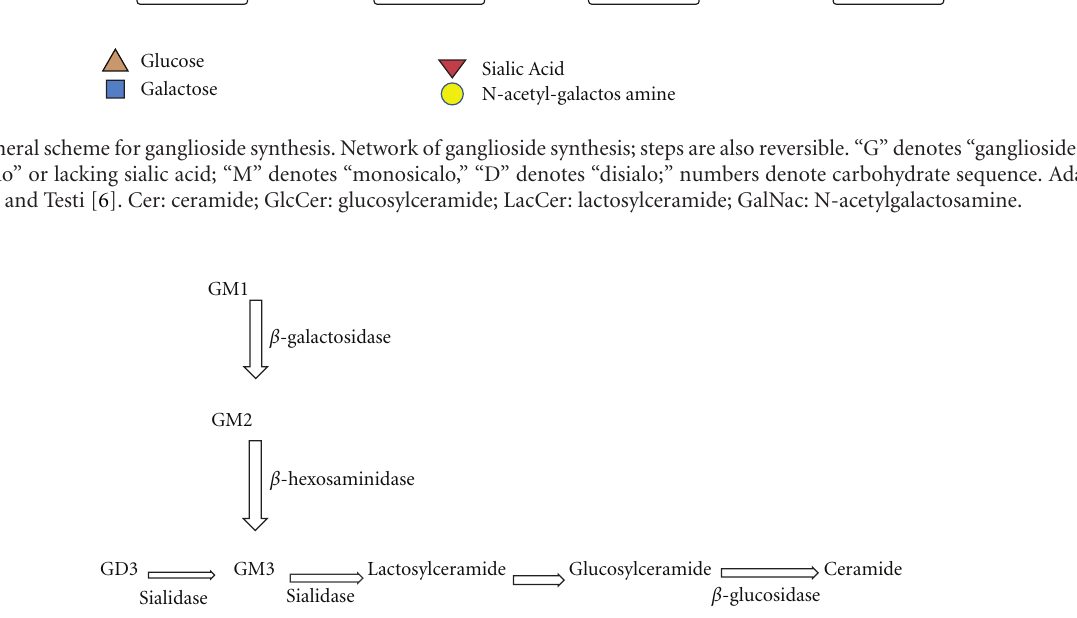
Figure 2: Ganglioside catabolism. Enzyme responsible for catabolic processing step is shown adjacent to arrow. Adapted from Devlin [11].